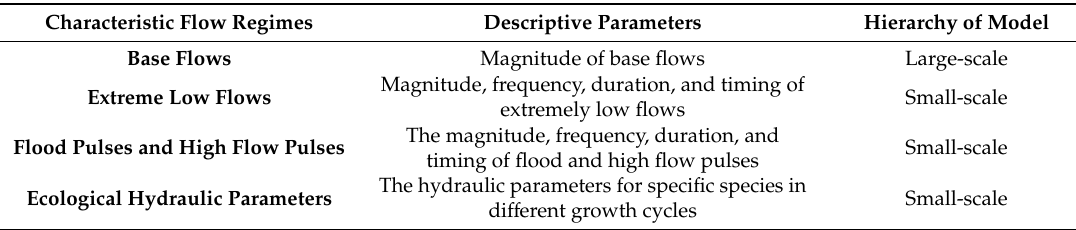
Table 2. Characteristic flow